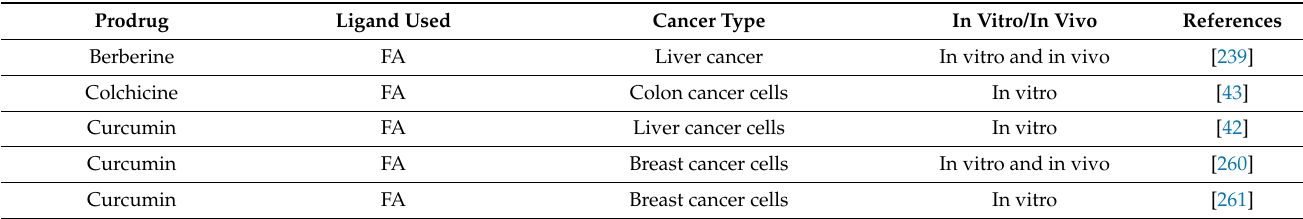
Table 7. Some examples of targeted delivery systems for anticancer natural prodrugs using MSNs. Prodrug Ligand Used Cancer Type In Vitro/In